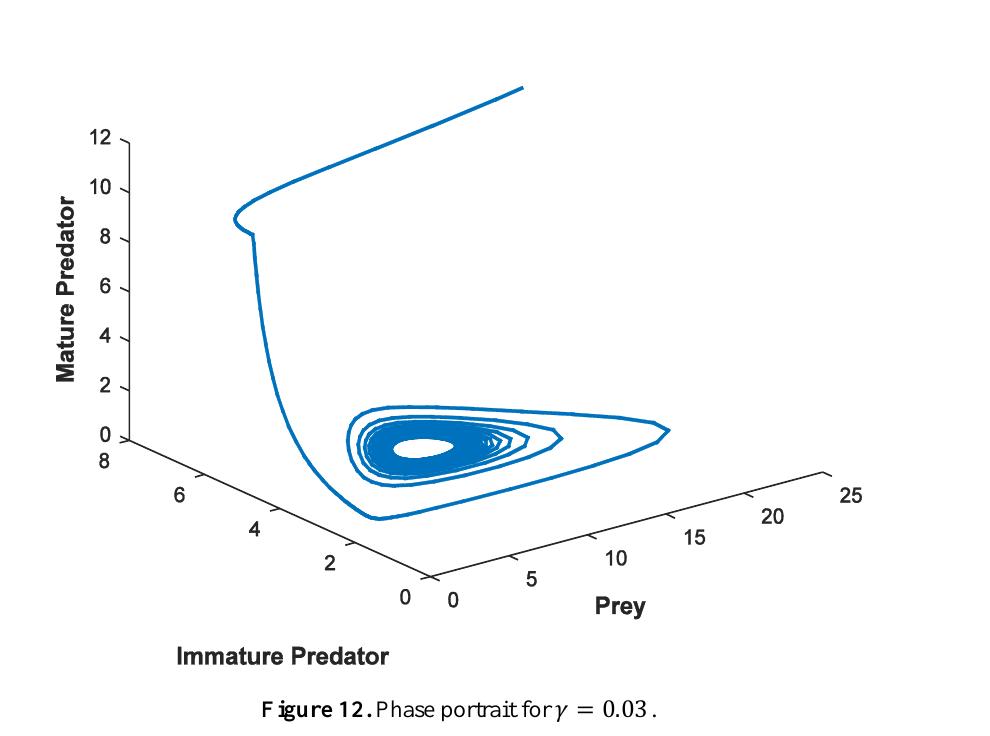
Figure 12. Phase portrait for 𝛾 = 0.03 .